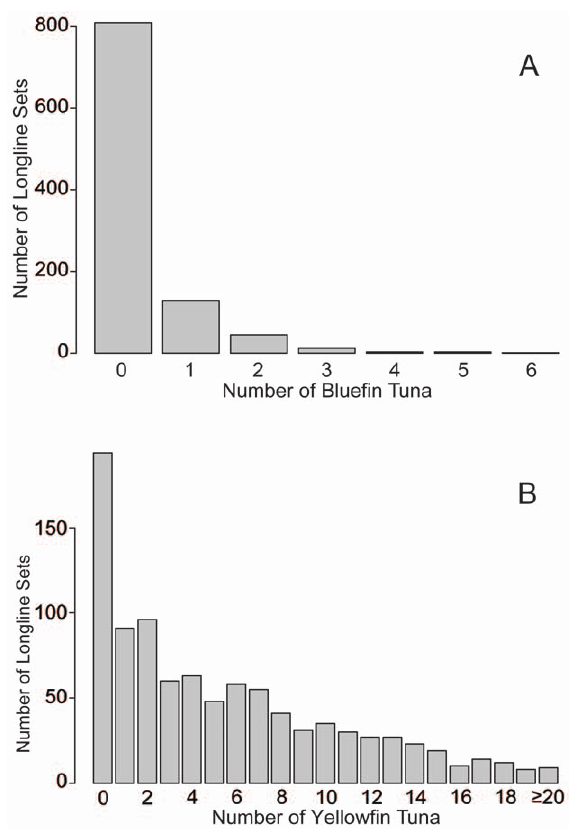
Figure 2. Numbers of bluefin and yellowfin tuna per longline set. Histograms show the number of (A) bluefin and (B) yellowfin tuna caught in each longline set.